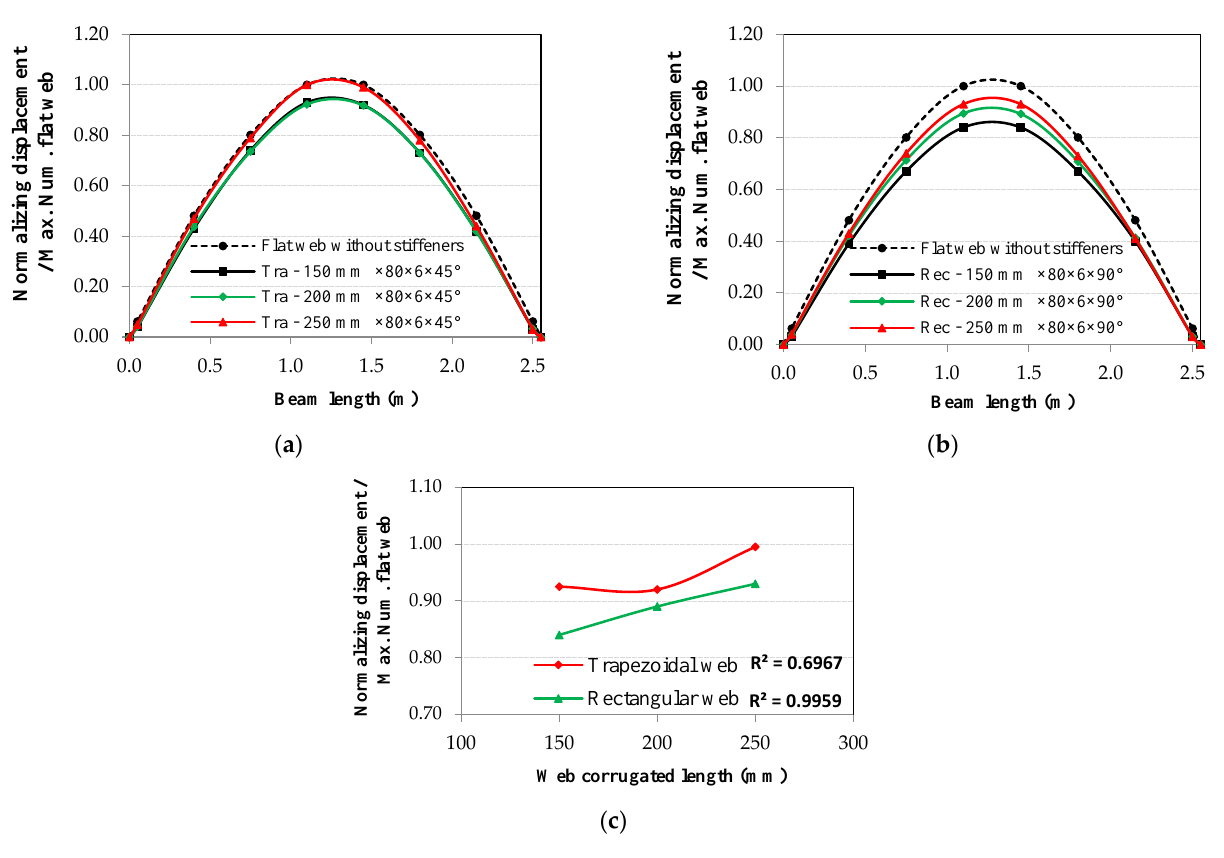
( b ) ( c ) Figure 16. Corrugated length effect on the relationship between normalized displacement and beam length for the 2nd mode shape: ( a ) trapezoidal web, ( b ) rectangular web, and ( c ) length effect at the 2nd mode shape.